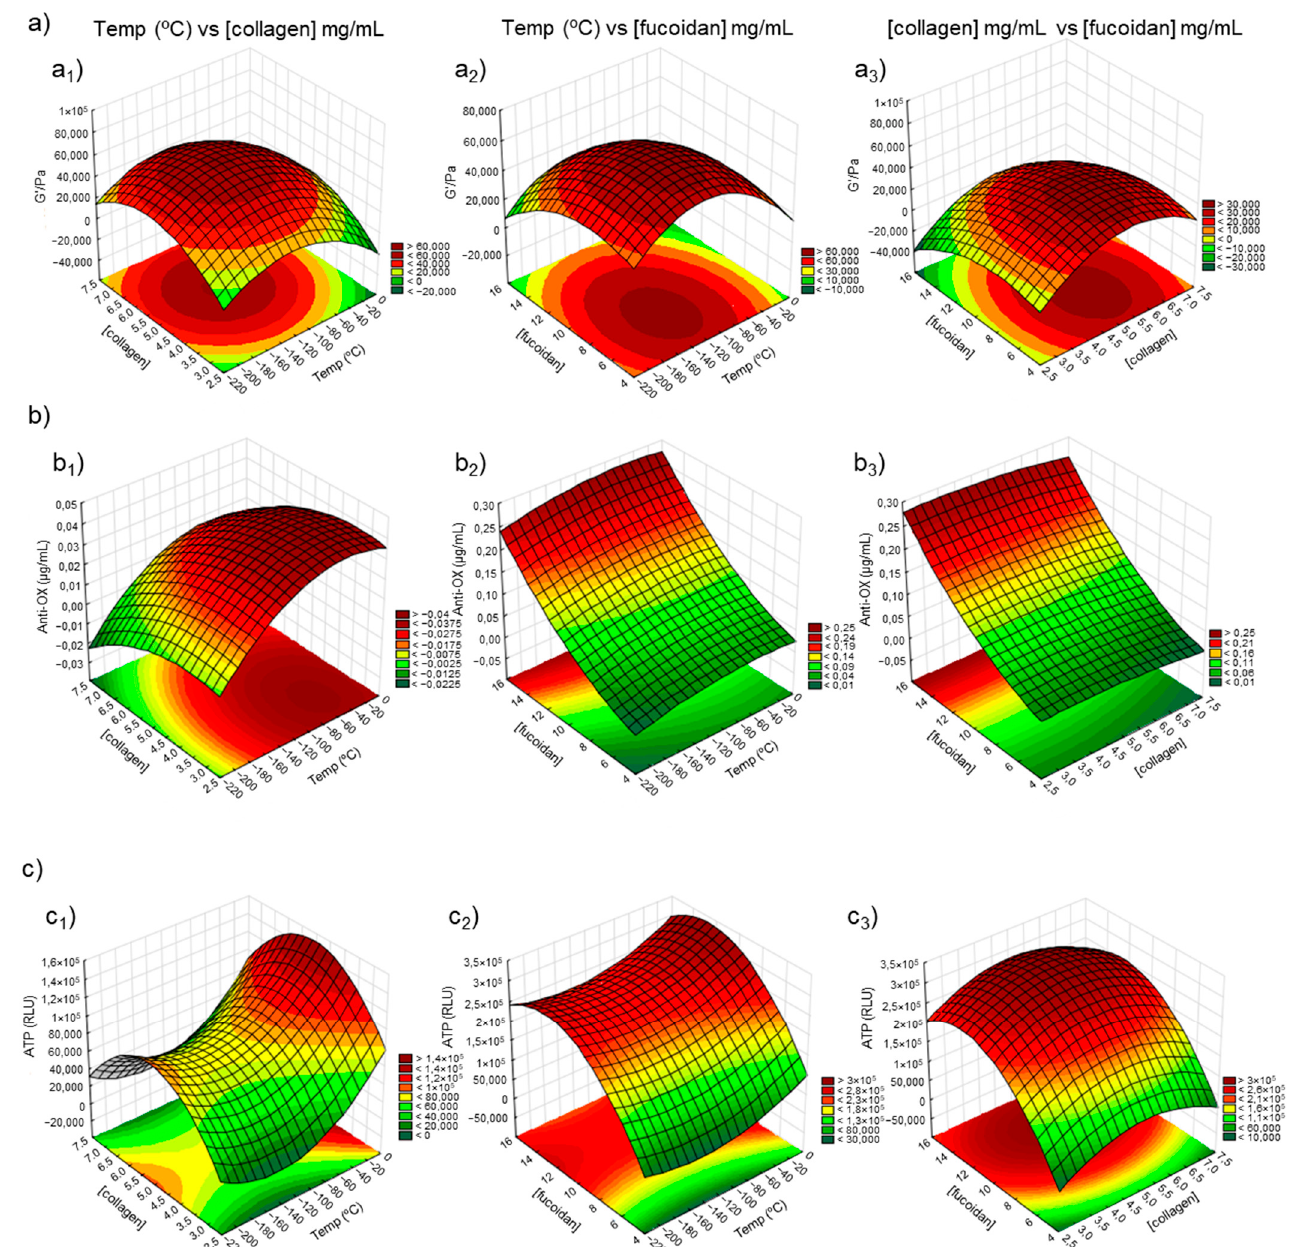
Figure 6. Factorial surface response of ( a ) rheological data (G ′ /Pa), ( b ) antioxidant activity (µg/mL), and ( c ) ATP (RLU) measurements on marine origin cryogels. The images of ( a 1 , b 1 , and c 1 ) demonstrate the correlation between the temperature (°C) vs. concentration of collagen ([collagen]); ( a 2 , b 2 , and c 2 ) represent the correlation between the temperature in relation to the concentration of fucoidan ([fucoidan]) while the images of ( a 3 , b 3 , and c 3 ) show the correlation between the concentration of collagen vs. the concentration of fucoidan.